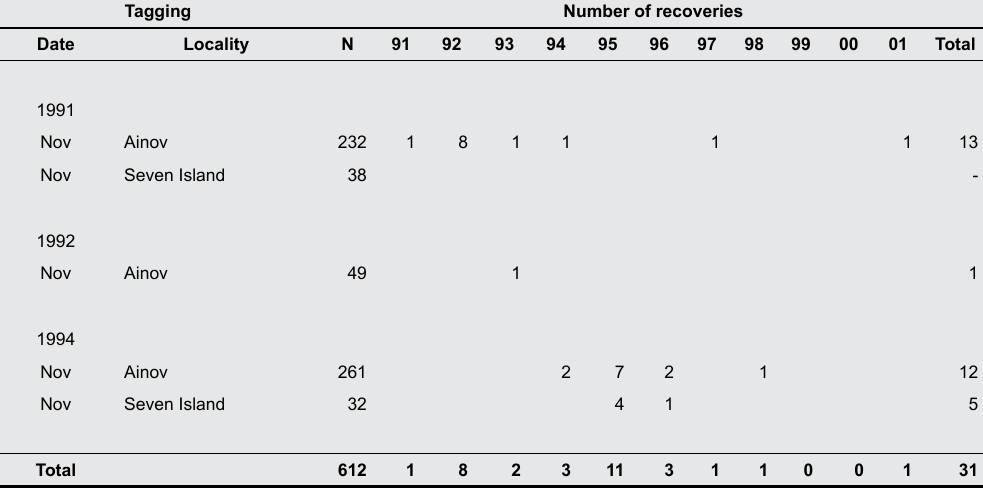
Table 1. Grey seals tagged on 2 breeding colonies (Ainov and Seven Islands) on the Murman coast, Russia, in 1991, 1992 and 1994, and recovered up to date 31 December